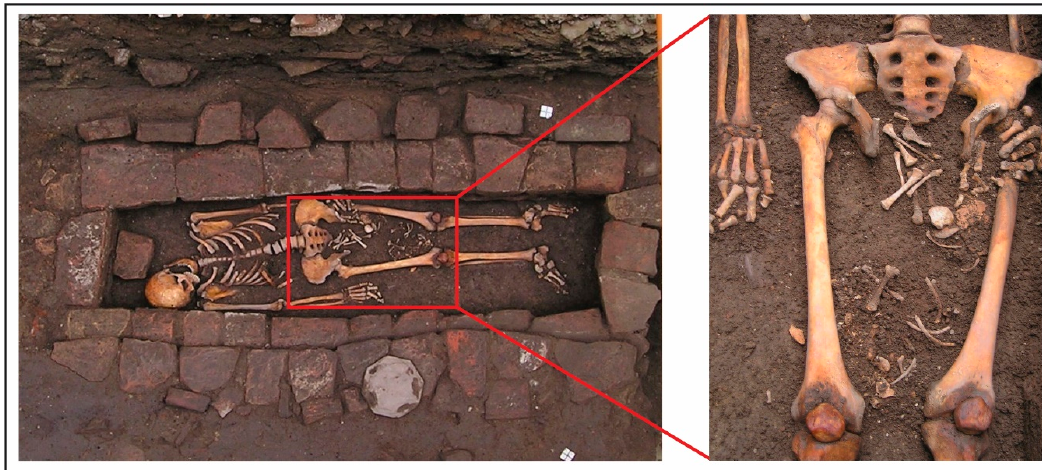
Figure 2. The seventh–eighth-century fetus discovered at Imola between the mother’s pelvis and the lower limbs (reproduced with the kind permission of Pasini and colleagues 2018, p. 79).